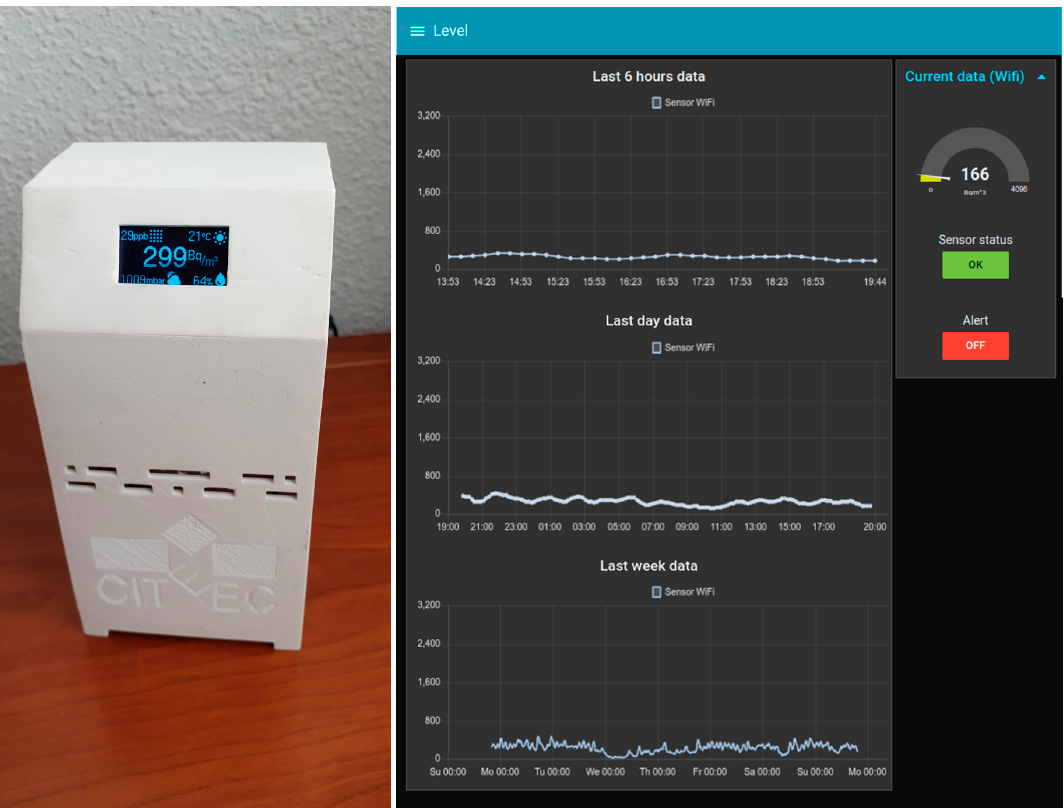
Figure 9. device photo (left) and system web interface (right). Figure 9. Device photo ( left ) and system web interface ( right